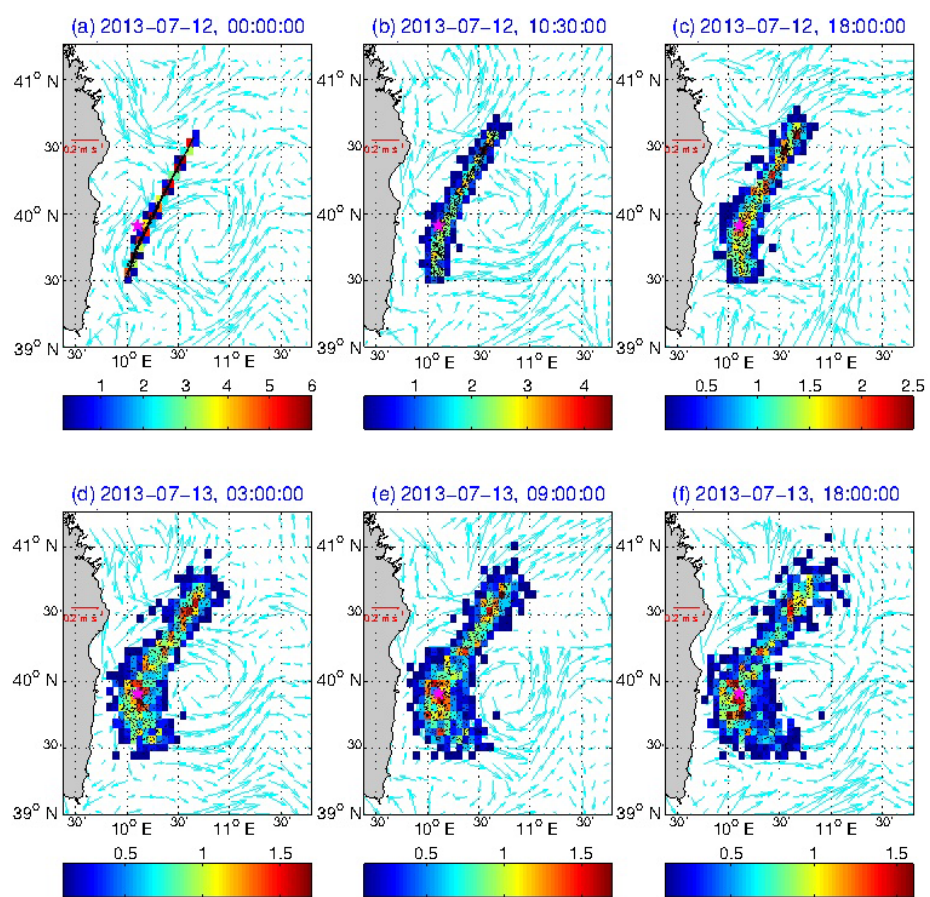
Figure 8. Here the standard error coefficients are set separately on the offset or on the slope of the regression line according to the wind velocity (blue lines in Fig. 5): for wind velocity lower than 10ms − 1 , the leeway perturbation coefficient is 4 times that in Breivik and Allen (2008) only on the offset of the regression line, while for wind velocity greater than 10ms − 1 , only that of the slope was changed. The particles’ cloud includes the target at the rescue time (panel (b) in the figure), and the dispersion is reduced with respect to that of the preceding